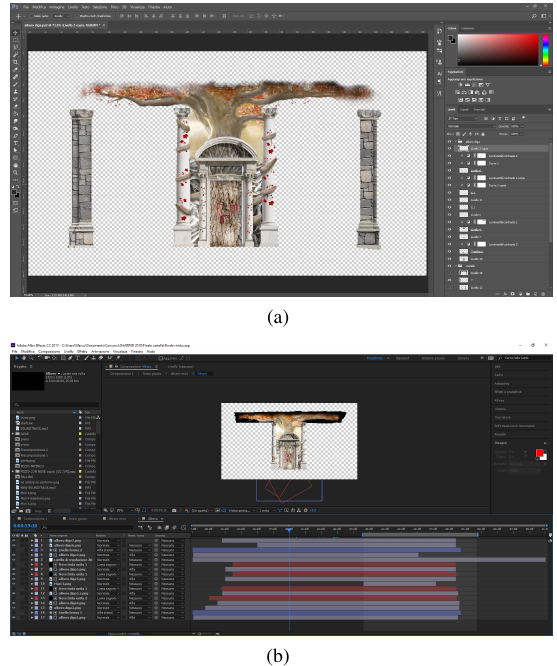
Figure 8. Two screenshots of the sw environment for Ice and fire video: the digital painting splitting the sequence into layers, the digital animation of video